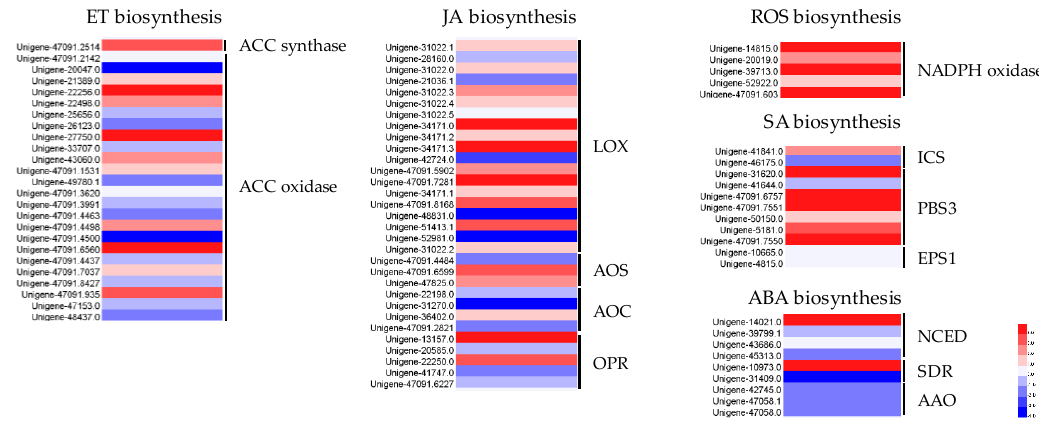
Figure 7. Expression patterns of the genes involved in the production of ET, JA, ABA, ROS, and SA in the D zone.